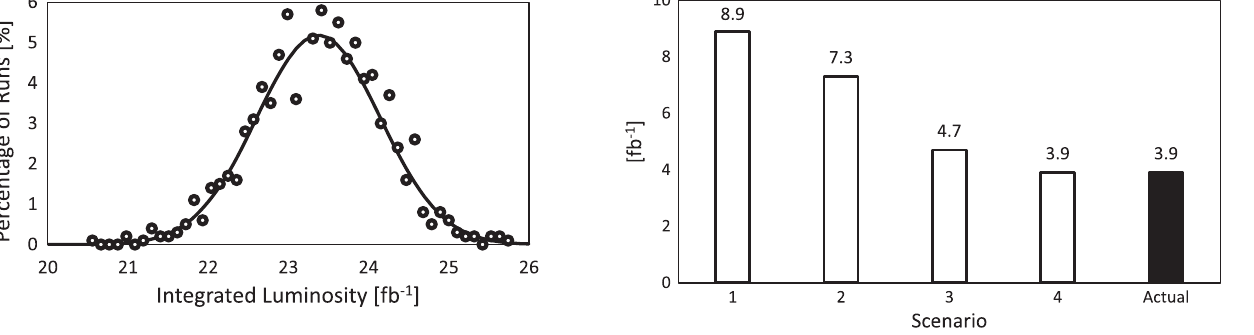
FIG. 10. Result distribution of 1000 model iterations with Gaussian fit.